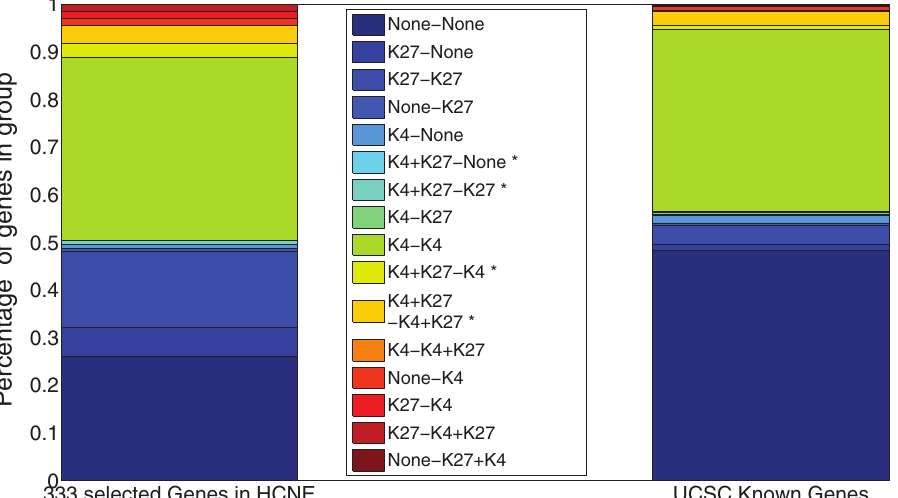
Figure 11. Bivalent regions in genes; (a) in 333 selected genes; (b) in UCSC known genes. Genes are attributed to classes according to the presence of modifications in ES and NP cells. The ‘‘A–B’’ notation in the labels indicates the presence of modification of type ‘‘A’’ in ES cells and modification of type ‘‘B’’ in NP cells. (*) marked labels have bivalent domains in ES cells.